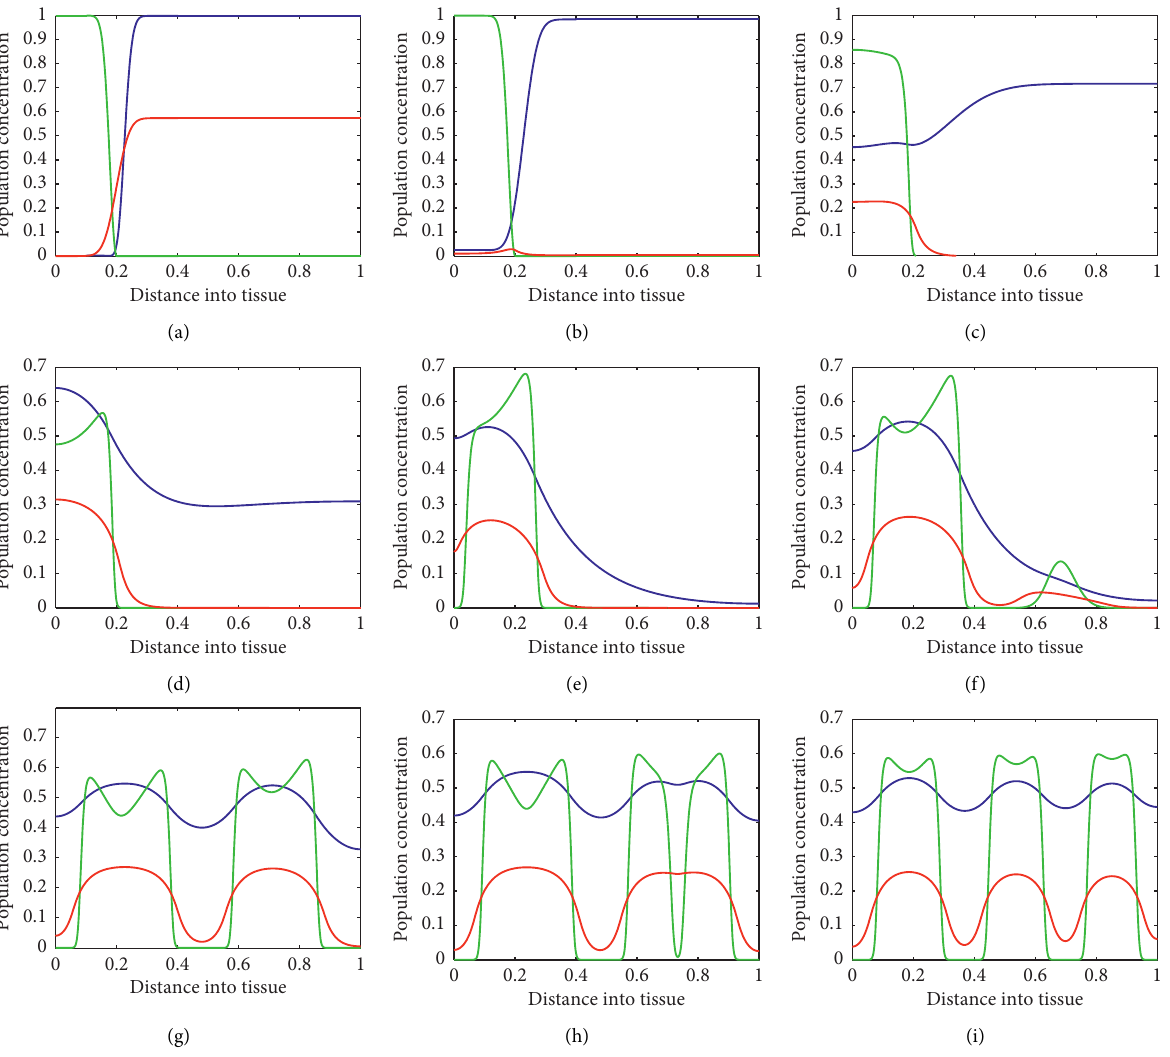
Figure 2: Evolution profiles of the effector cell (blue), the cancer cell (green), and IL-2 (red) concentrations for the cancer cell random � 0 . 0000199. (a) t � 0.01. (b) t � 0.1. (c) t � 2. (d) t � 7. (e) t � 60. (f) t � 110. (g) t � 140. (h) t � 290. (i) t � motility coefficient d 2